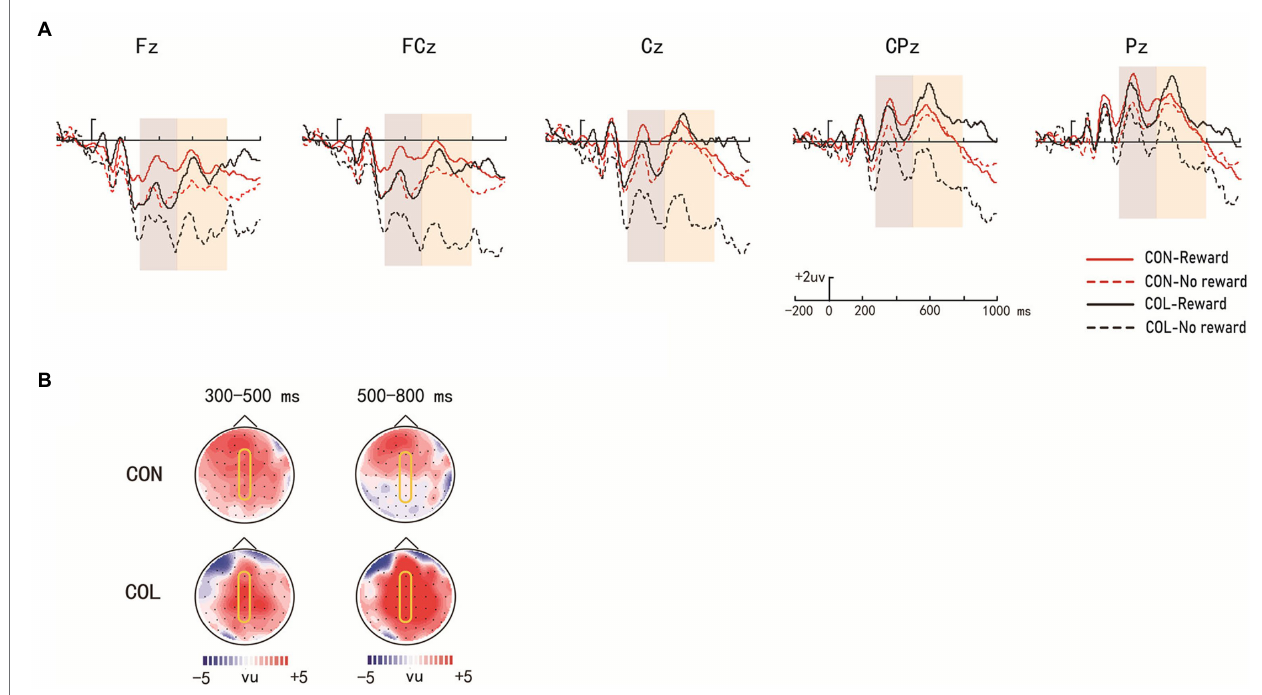
FIGURE 4 | Amplitude distribution and topographic maps of ERP measurements of reward effects for intact items during retrieval. (A) Amplitude distribution of ERP measurements in relation to reward effects and encoding task effects. (B) Topographic maps of ERPs on reward effects in the items encoded through the two encoding